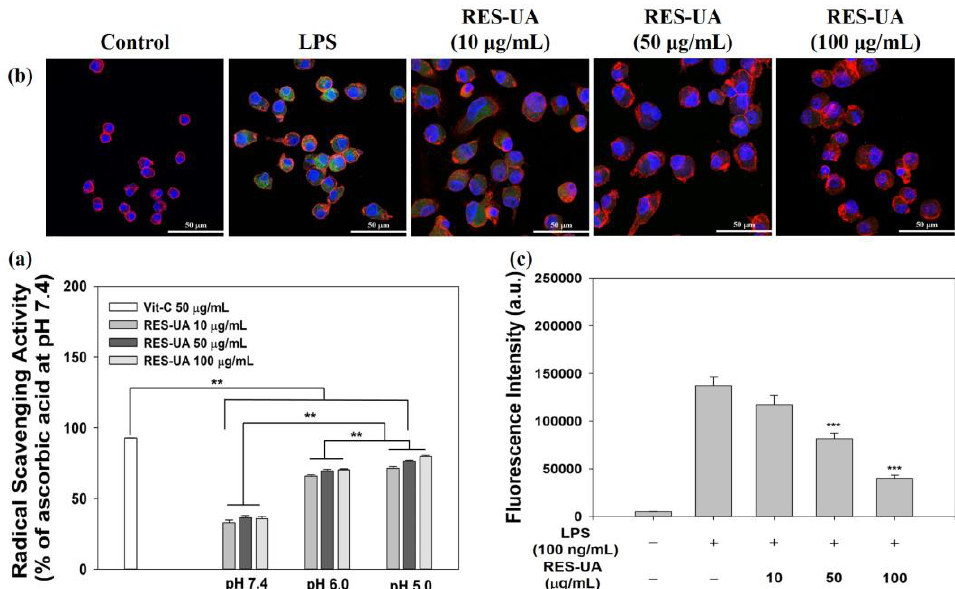
Figure 7. ( a ) Antioxidant activity according to various concentrations of RES-UA NPs as determined by assessing ABTS scavenging activity. ( b ) Fluorescence images of intracellular ROS formation in RAW 264.7 cells stimulated with LPS for 24 h after pre-incubation with various concentrations of RES-UA NPs for 1 h. ( c ) Fluorescence intensity due to intracellular ROS generation in RAW 264.7 cells stimulated with LPS for 24 h after pre-incubation with various concentrations of RES-UA NPs for 1 h. p -values are for comparison between RES-UA NP- and LPS-stimulated cells. Values are presented as means ± SDs. *** p < 0.0001 and ** p < 0.001; n = 4 per group. Scale bar: 50 μ m.